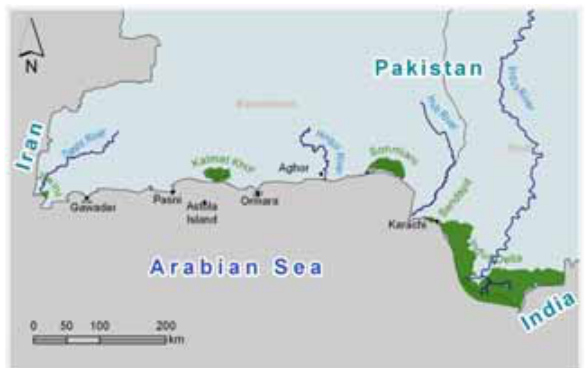
Figure 7: Mangroves Forest sites in Pakistan In addition to satellite images, GIS layers containing topographic information such as administrative boundaries, populated places, creeks, roads, etc., were digitized from Survey of Pakistan (SoP) topographic sheets of 1:50,000 scale.